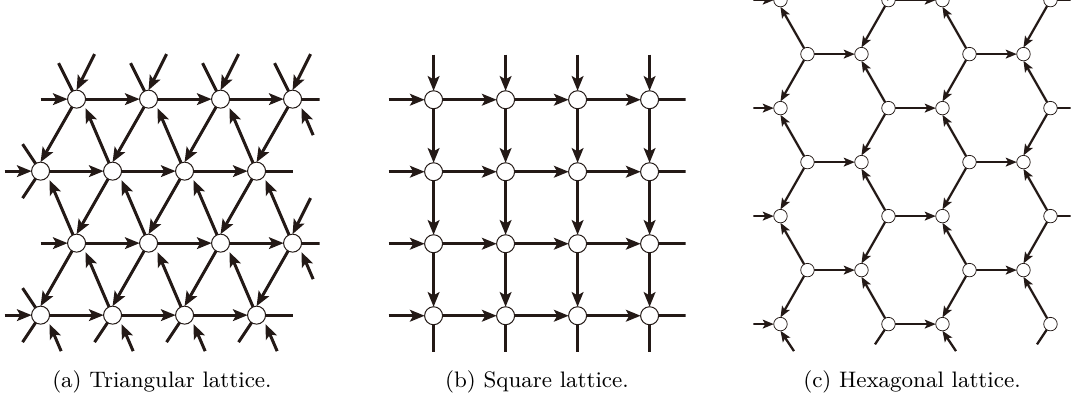
Figure 1. Discretizations of a flat plane or torus T 2 can be obtained from graphs. The original KM model is defined on the square lattice graph (b). In this sence, the gKM model has possibilities for constructing various kind of discretized scalar field theories by choosing the graph